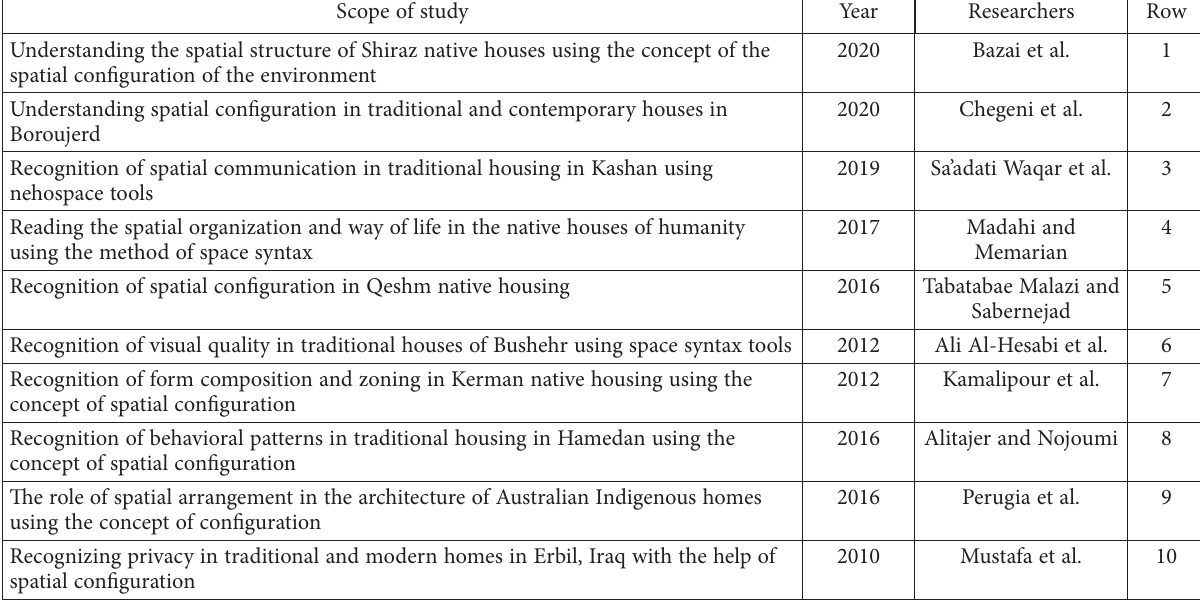
Table 1. Research background, research on housing spatial configuration (source: compiled by the authors) RowResearchersYearScope of